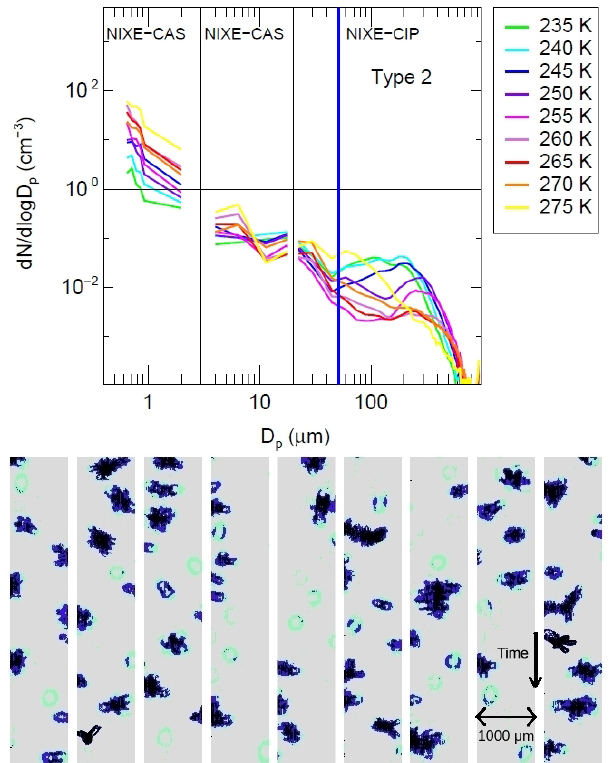
Figure 8. Same as in Fig. 7 but for Type 2